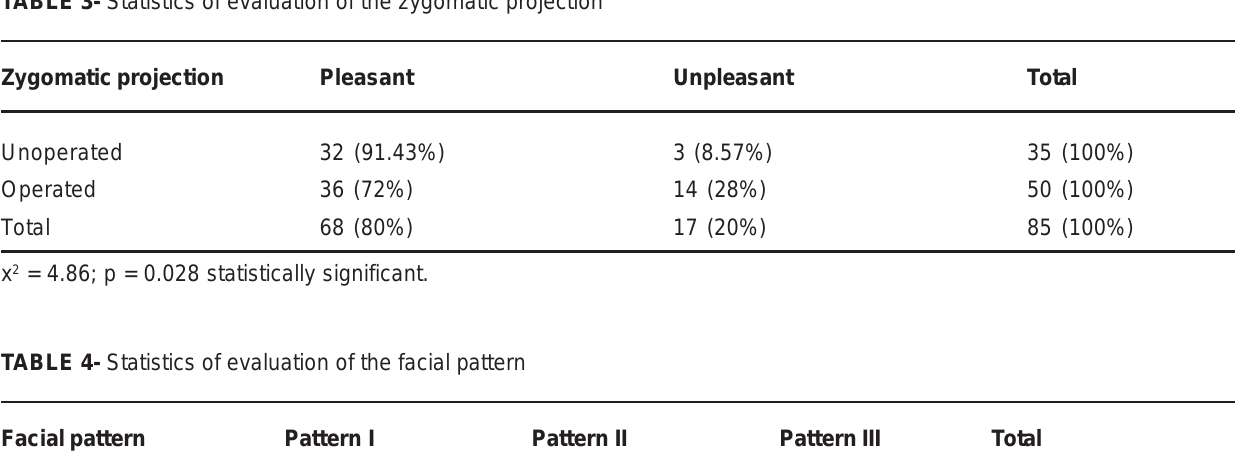
TABLE 3- Statistics of evaluation of the zygomatic